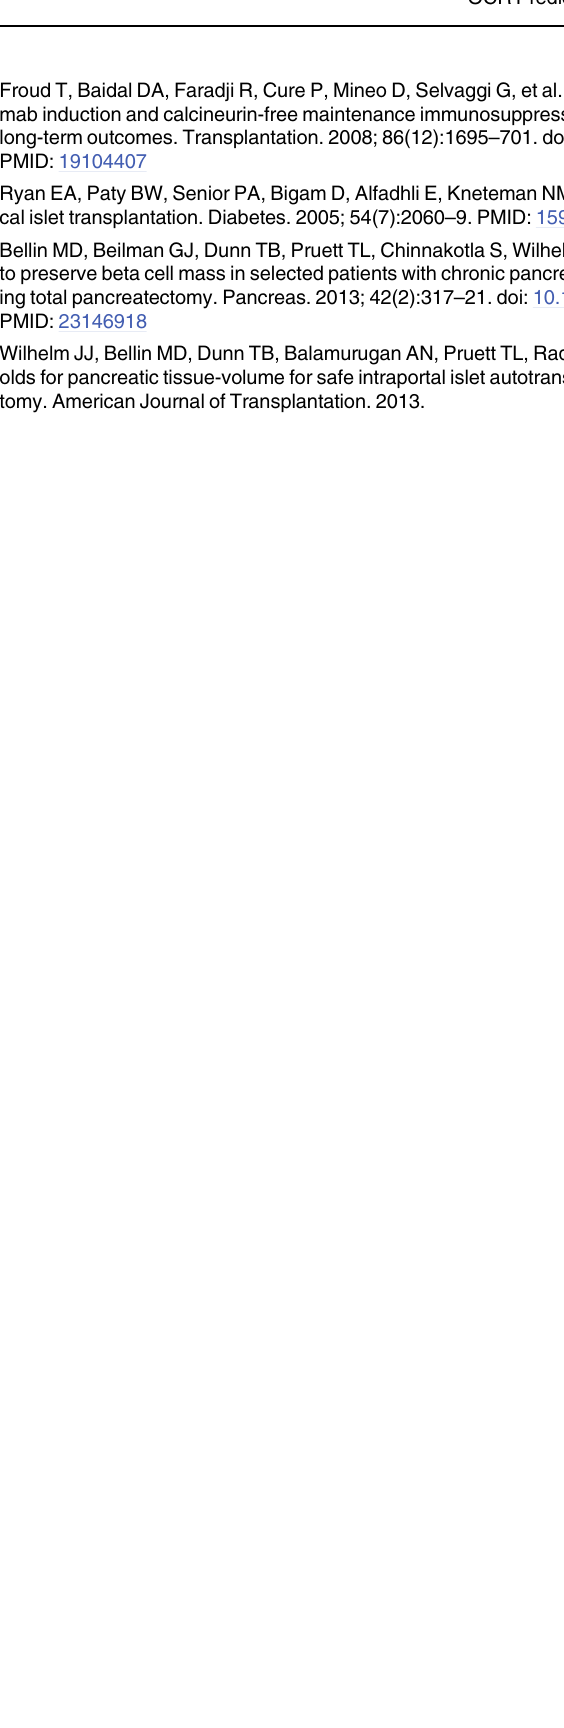
PLOS ONE | DOI:10.1371/journal.pone.0134428 August 10,